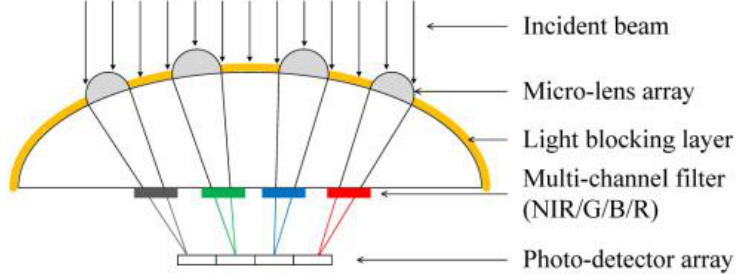
Figure 41. Schematic of the multi-layer artificial compound eye.